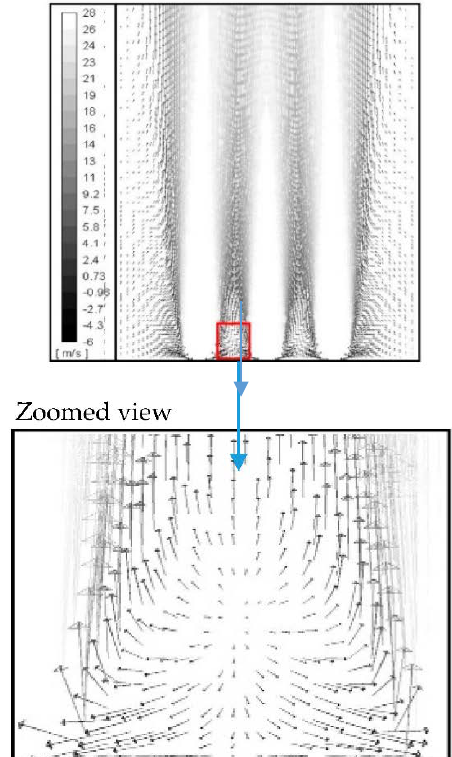
Figure 13. Radial velocity contours in the centerline plane.